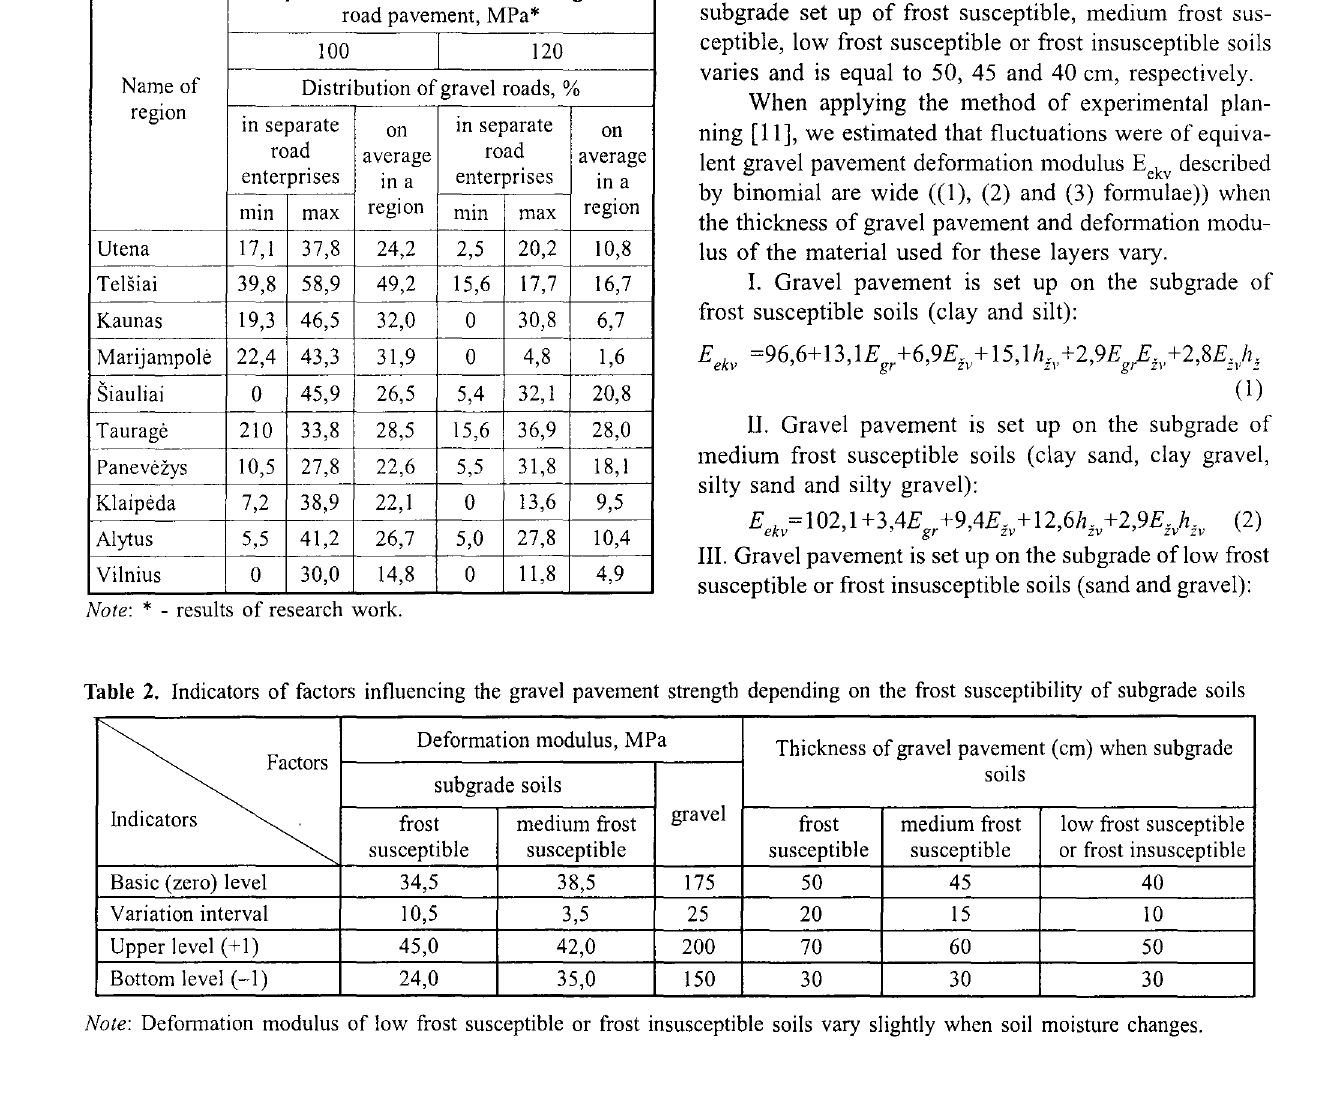
Table 1. Distribution of gravel roads (in percent) by the required deformation modulus